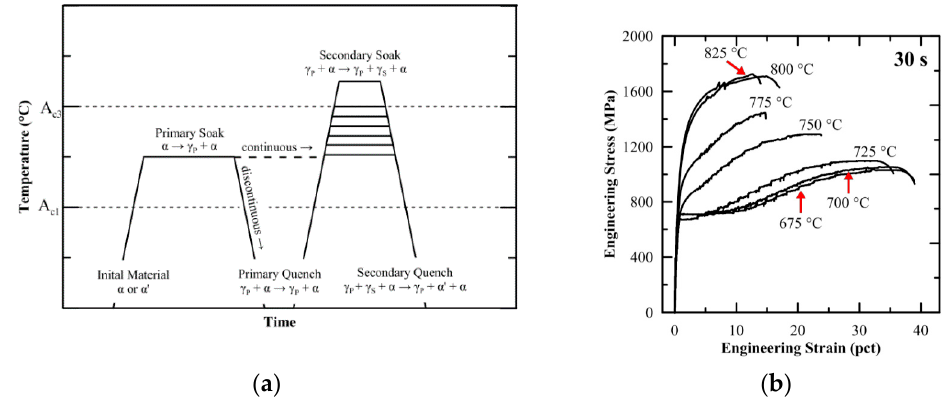
Figure 2. Schematic illustration of double soaking thermal treatments ( a ), and tensile properties ( b ) for a 7.14 Mn, 0.14 C (wt. pct.) steel after a second soak of 30 s at indicated temperatures [10].